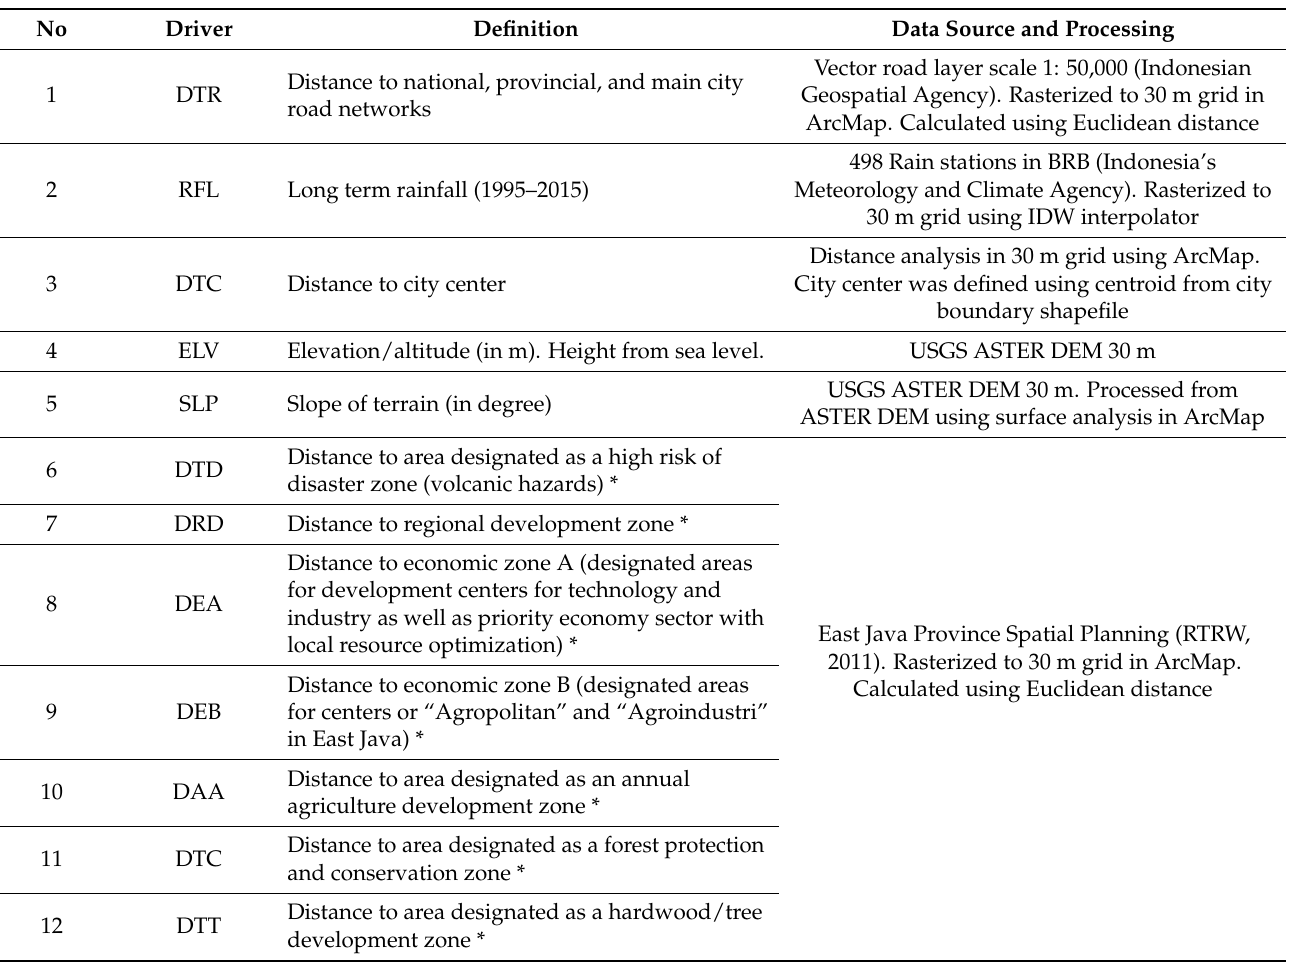
Table 2. Twelve selected land-use change drivers from PCA